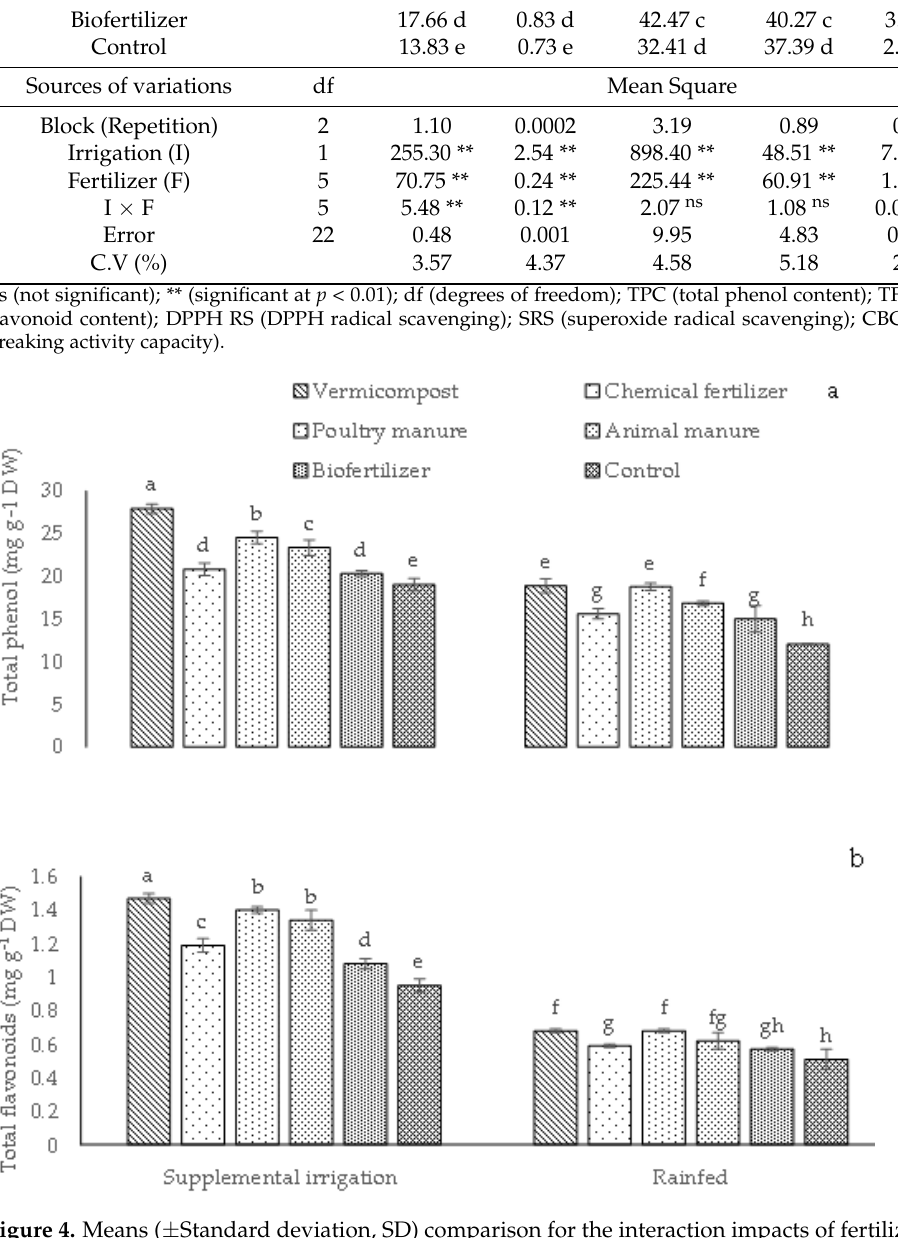
Figure 4. Means ( ± Standard deviation, SD) comparison for the interaction impacts of fertilizer and irrigation conditions on total phenol ( a ) and total flavonoids ( b ). DW: dry weight. The means with different letters differ significantly at p ≤ 0.05 based on Tukey’s HSD